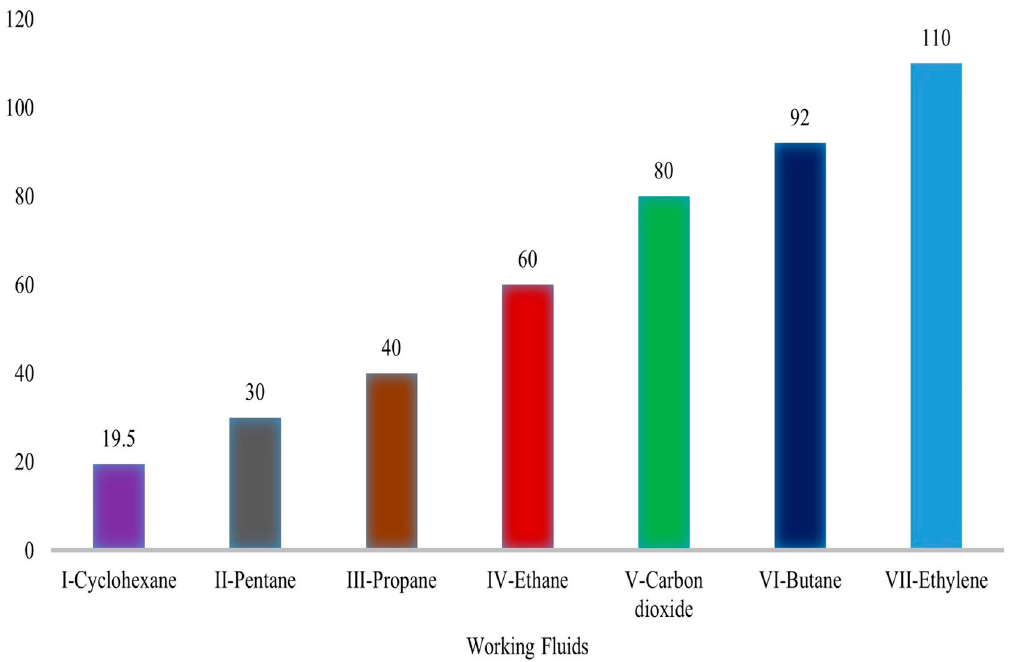
Figure 10. Illustration on the obtained NPV of the configurations placing working fluid in single modes.